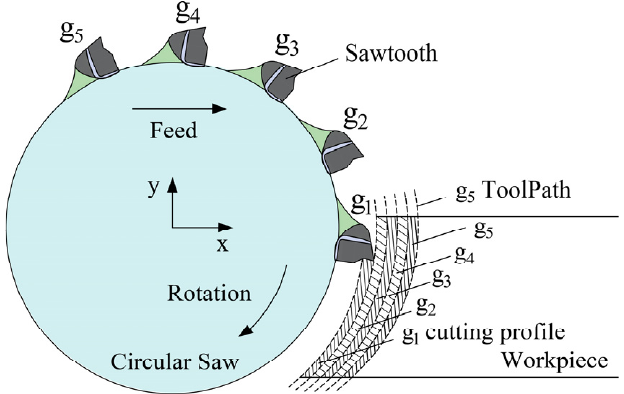
Figure 10. Schematic diagram of chip formation by circular sawing.